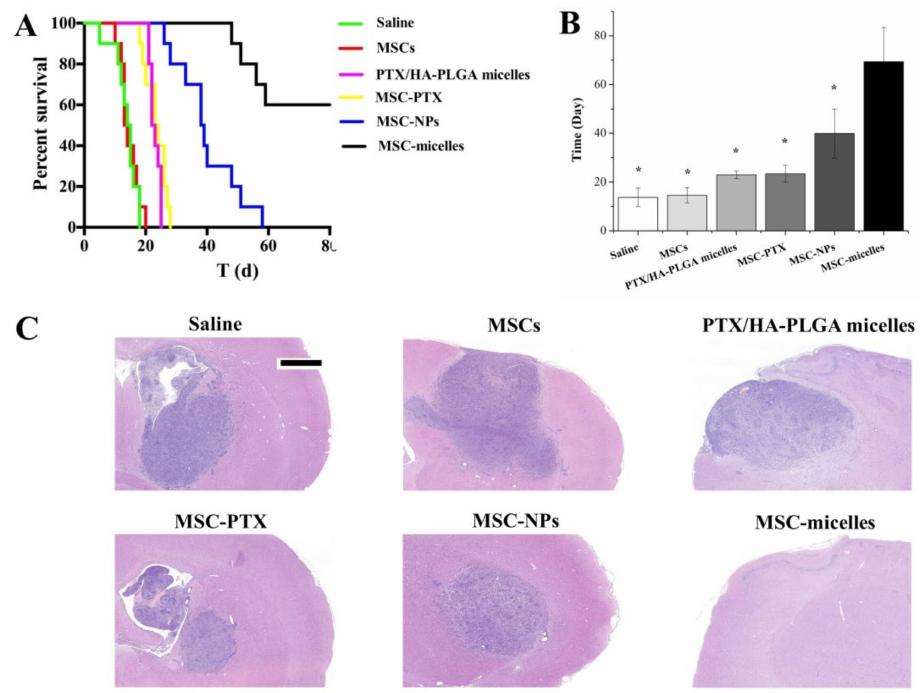
Figure 8. ( A ) Kaplan–Meier survival curve ( n = 10). ( B ) Median survival time (* p < 0.05). ( C ) H&E sections of tumor tissues from C6 glioma-bearing rats. The samples were collected on the 7th day after therapeutic injection (bar = 1